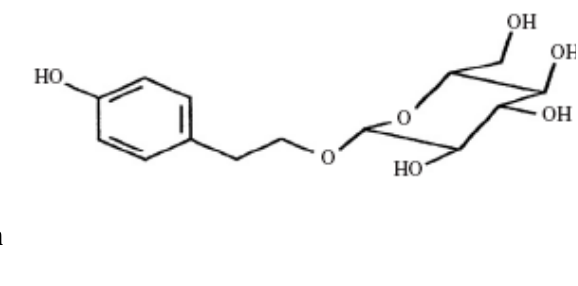
Figure 1. Molecular structure of salidroside.